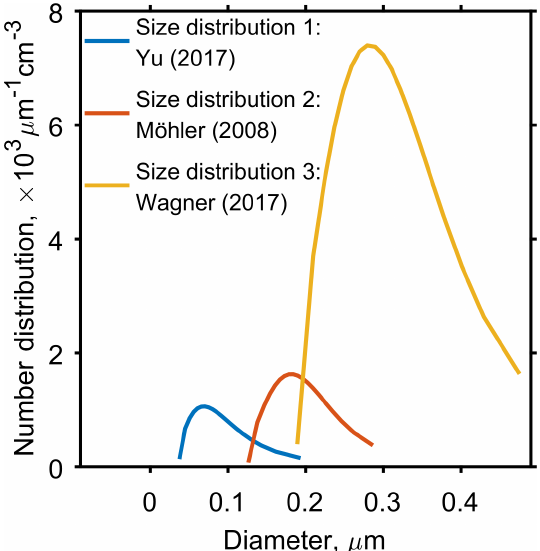
Figure 2. Three aerosol particle size distributions used to initiate the cloud parcel models, which have been taken from published stud- ies. Yu et al. (2017), corresponds to secondary organic aerosol data collected near the tropopause in Kunming, China, and both Möhler et al. (2008) and Wagner et al. (2017) correspond to aerosol size dis- tributions used in cloud chamber experiments. Table 2 found in the Appendix gives specific parameter values for the log-normal size distributions.